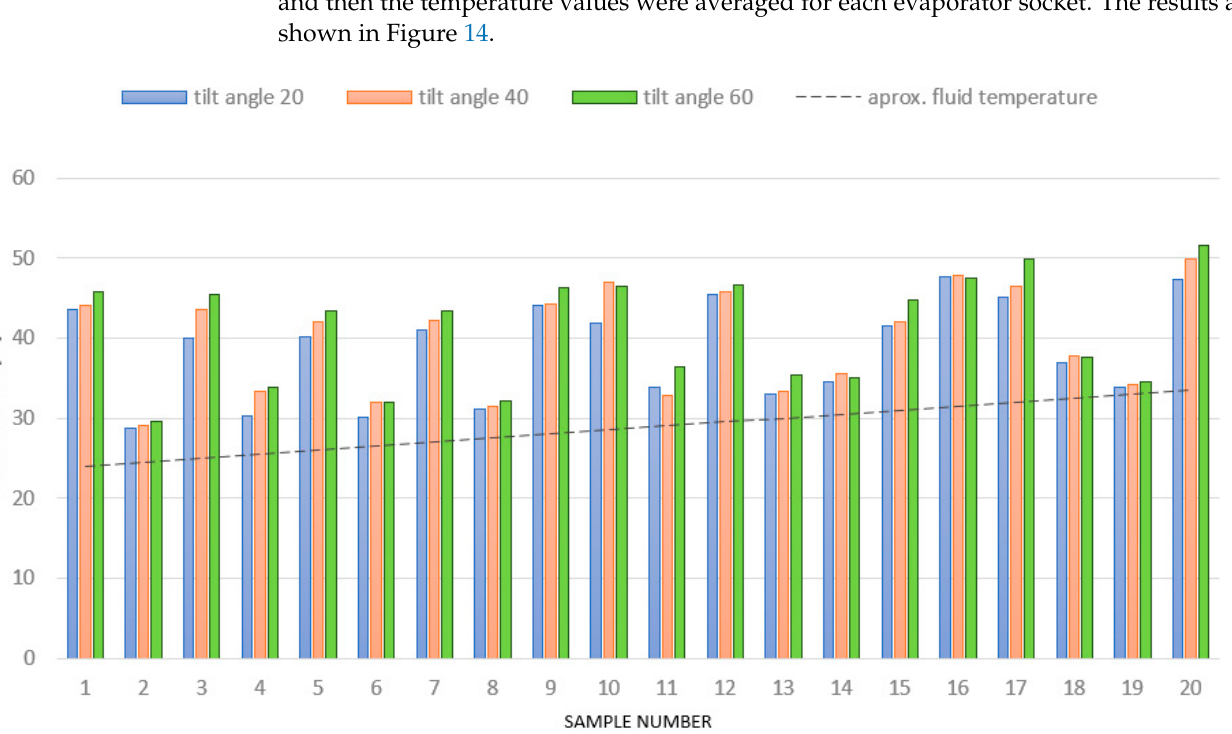
Figure 14. Summary of the thermographic tests results of the manifold surface.